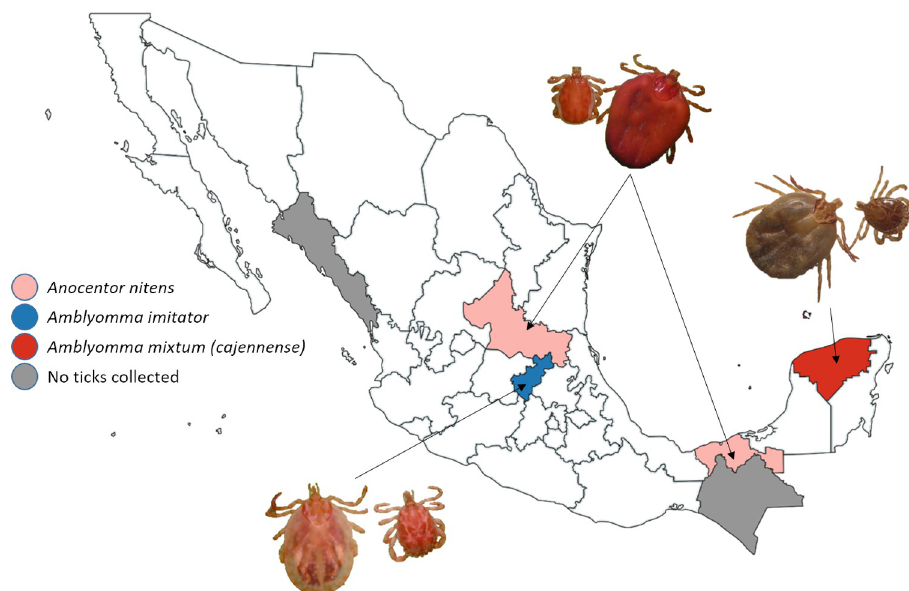
Fig 2. Taxonomy analysis results. Ticks from Tabasco and San Luis Potosi (pink). Ticks from Queretaro (blue) and ticks from Yucatan (red). No ticks were found on equines from Sinaloa and Chiapas